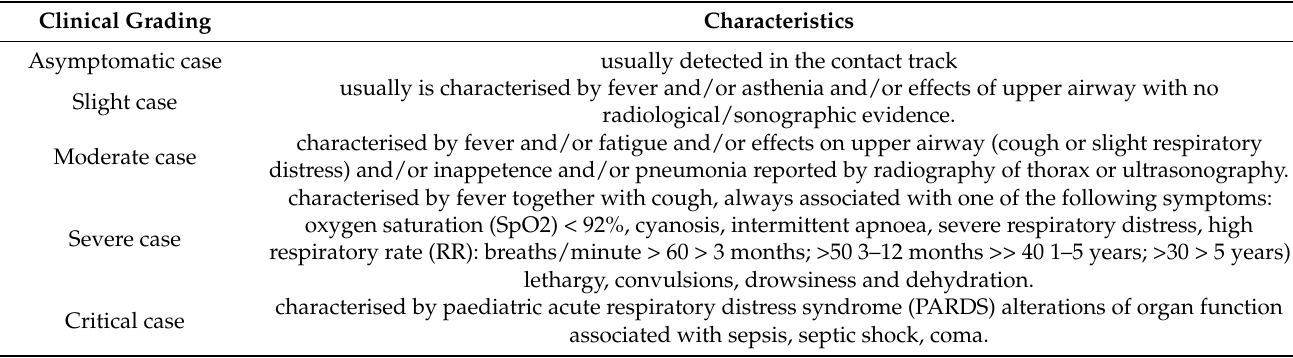
Table 1. Summary of the COVID-19 grading and clinical characteristics [188,189].